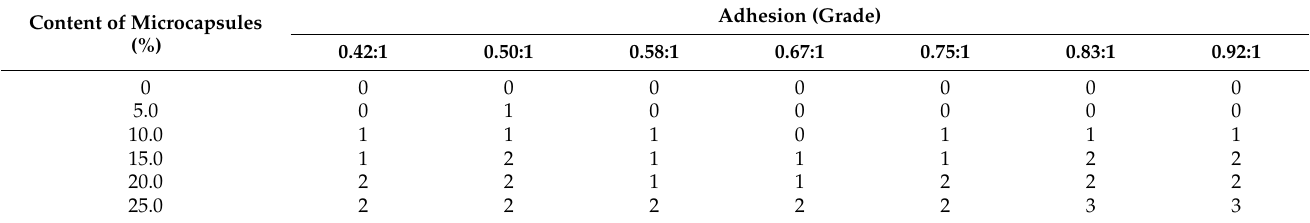
Table 4. Variation of adhesion of water-based topcoat paint